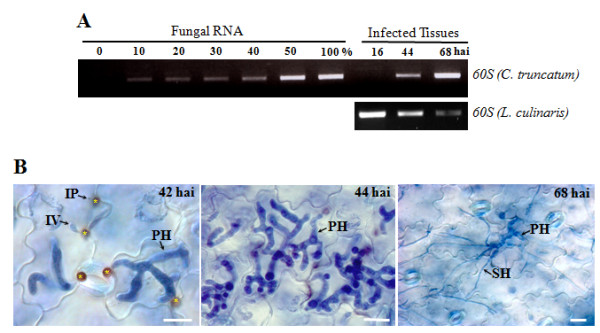
Evaluation of plant and fungal contents in infected lentil leaflet tissues, and cytological analysis of an infection time-course. (A) Semiquantitative RT-PCR amplification of the C. truncatum and L. culinaris 60S ribosomal transcripts in the appressorial penetration phase (16 hai), biotrophic phase (44 hai) and necrotrophic phase (68 hai). Fungal 60S transcripts were also qualitatively assessed in control mixtures, which were obtained by combining 0, 10, 20, 30, 40, 50, and 100% RNA from fungal mycelium into RNA from mock-inoculated leaflets. Twenty six cycles were used for amplification. (B) In planta infection time- course. C. truncatum infected lentil leaflets cultivar 'Eston' at 42-44 hai represent the biotrophic phase characterized by large intracellular primary hyphae and the necrotrophic phase at 68 hai. *Appressorium, IP, Infection peg. Bars = 10 μm.